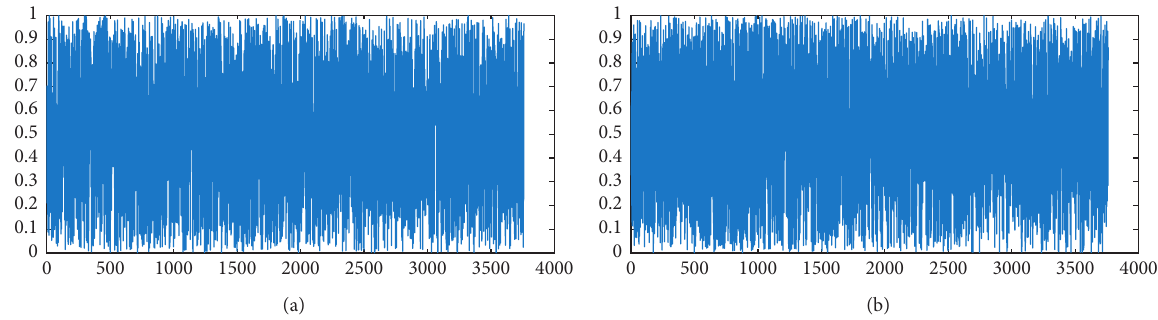
Figure 5: Marginal distributions of z